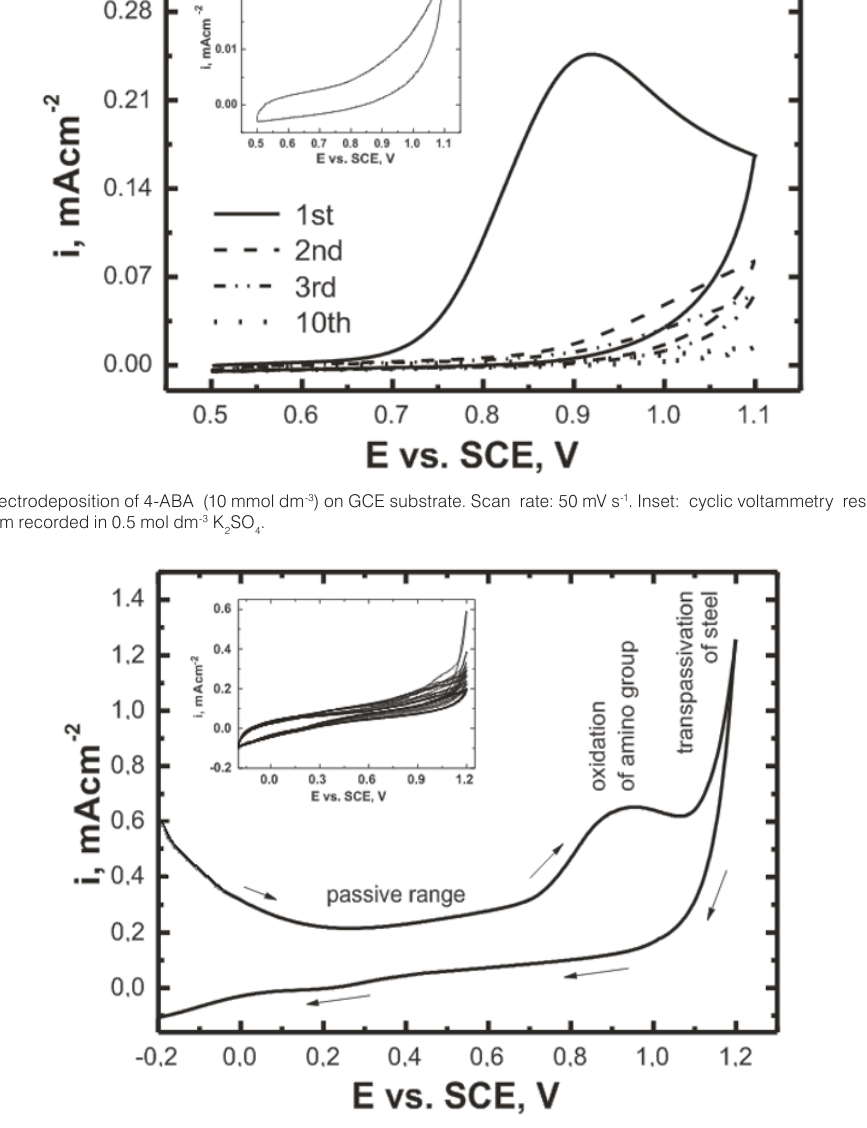
Figure 3. Cyclic voltammograms illustrating the first cycle electrodeposition of the 4-ABA film on stainless steel. Inset: 2 nd to 10 th cycles. Scan rate, 50 mV s -1